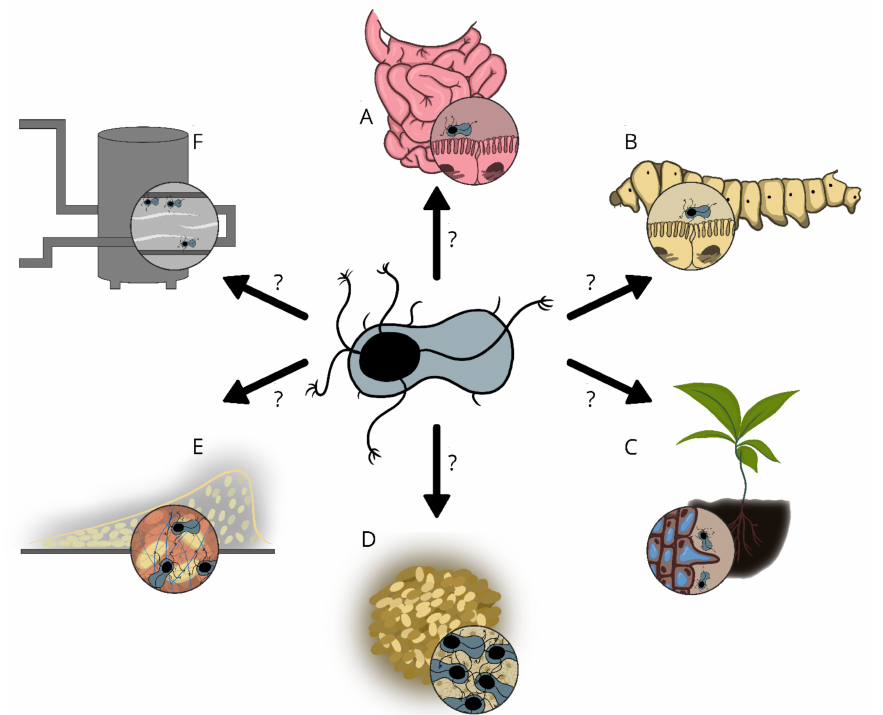
Figure 4. An illustration depicting potential roles that Enas may play in Bacillus s.l. spp. Adhesion of endospores to intestinal epithelial cells ( A ), insect tissues (larvae) ( B ), and plant roots ( C ). ( D ) Autoaggregation of endospores. ( E ) Biofilm formation. ( F ) Adhesion of endospores to abiotic surfaces, such as food processing surfaces. The pictures are not drawn to